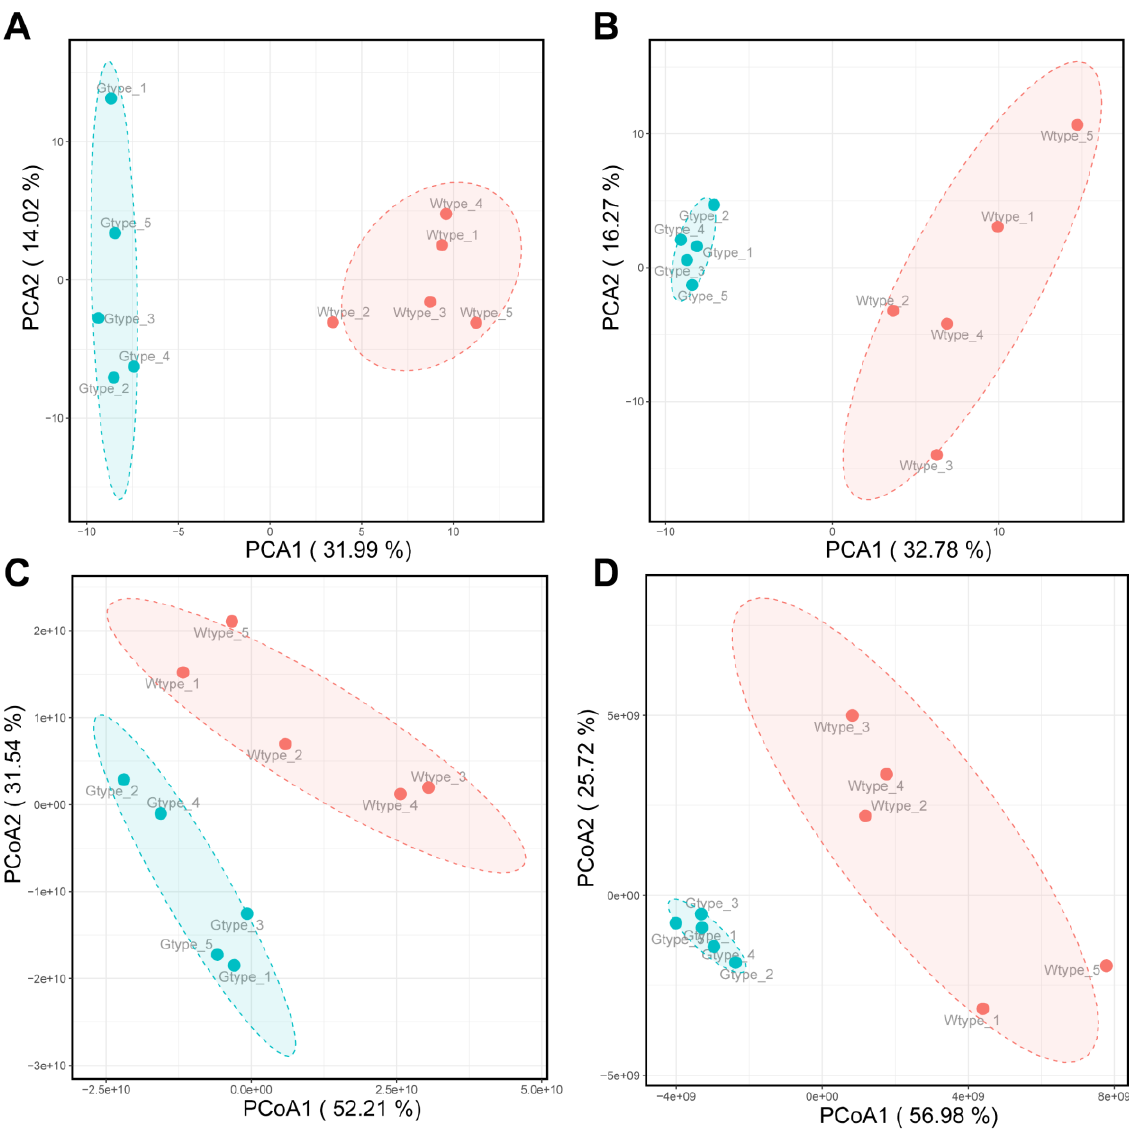
Figure 3. PCA score plots of the tentatively identified metabolites acquired in positive ( A ) and negative ( B ) ionization modes. PCoA score plots of the tentatively identified metabolites acquired in positive ( C ) and negative ( D ) ionization modes.